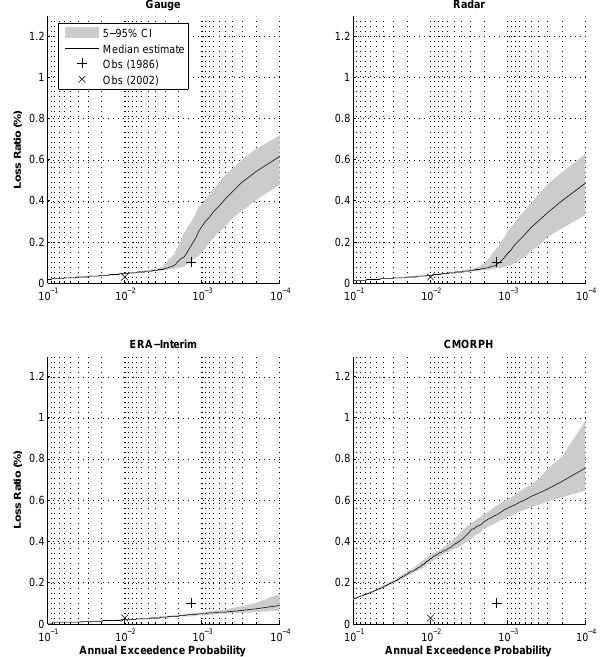
Figure 5. Exceedance probability plots produced by the catastro- phe model when trained using the four different precipitation data sets. The grey shaded area denotes the 5–95% confidence intervals generated by the financial model. The losses simulated when the hydraulic and vulnerability modules are driven with observed flows for two historical events are shown for